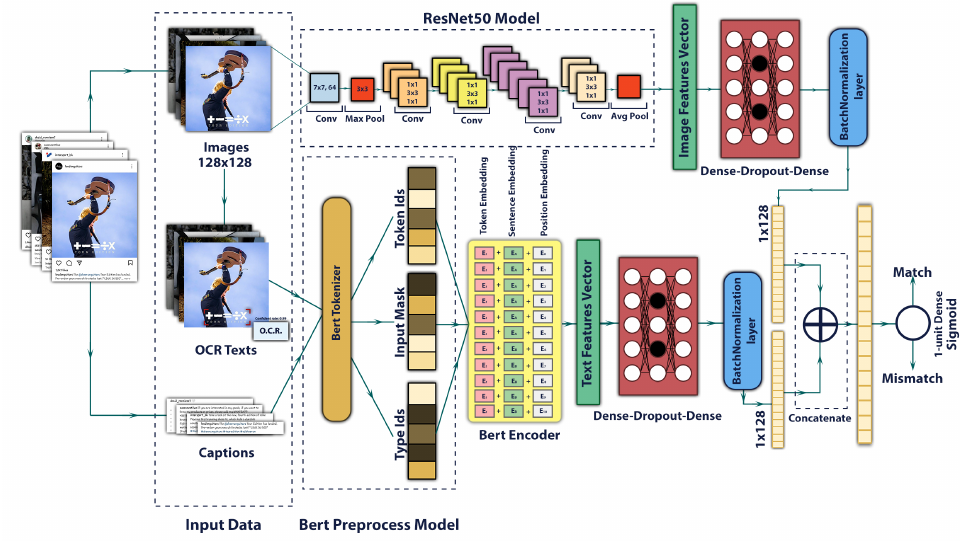
Figure 3. The proposed hybrid multimodal deep learning